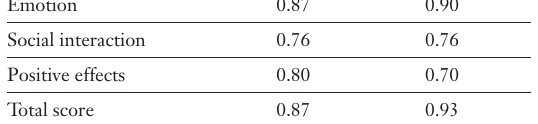
Cronbach alpha for each domain individ- ually and the total score for the AAQOL and the AAQOL-D.